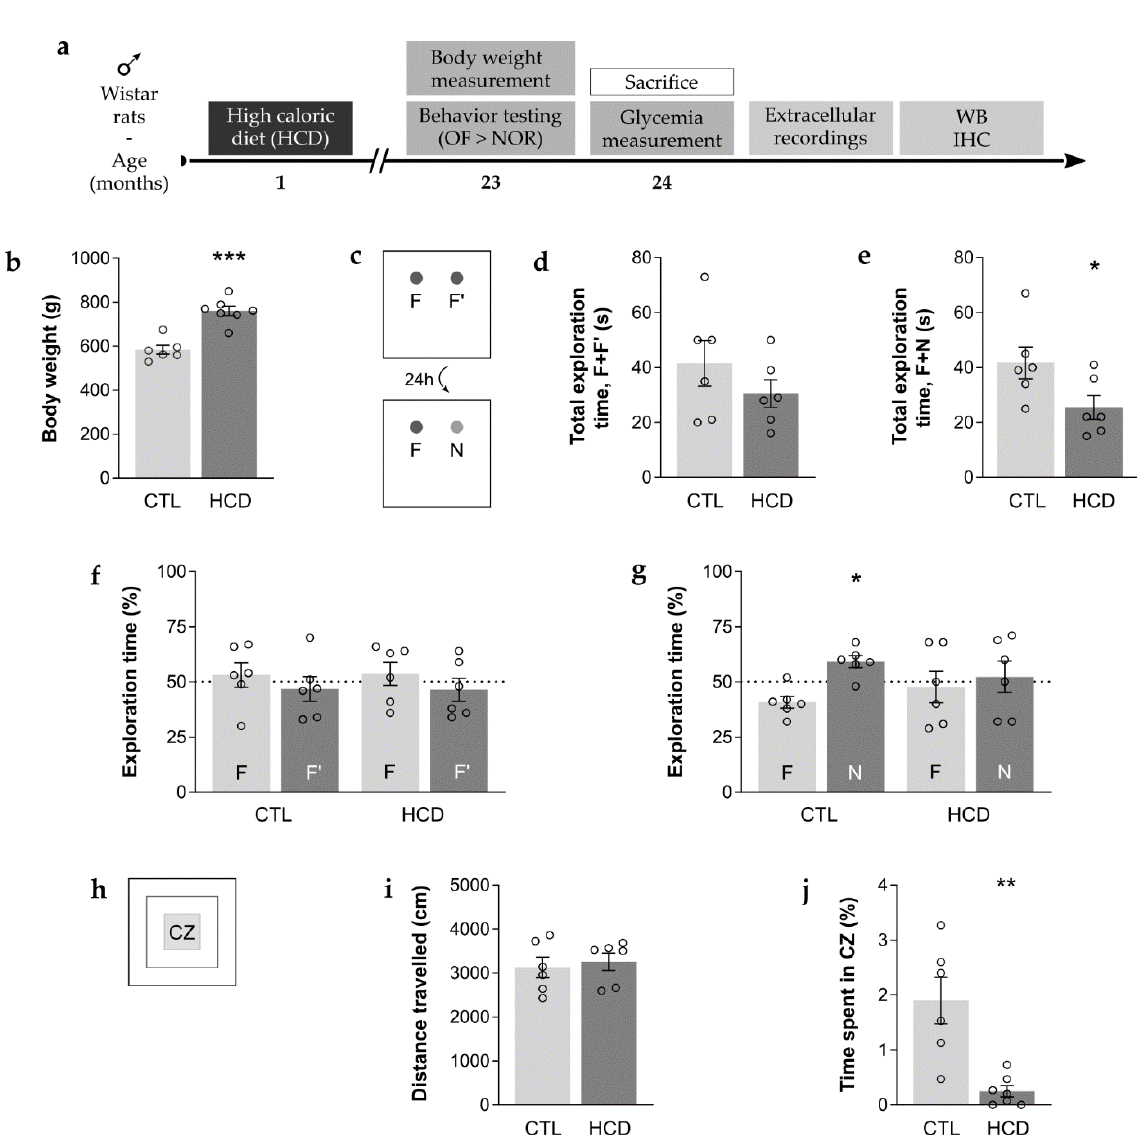
Figure 1. A chronic high caloric diet (HCD) induced obesity, enhanced long-term memory impairment and anxious-related behavior. ( a ) Experimental timeline. Rats were kept on a high caloric diet (HCD) starting at 1 month of age, until